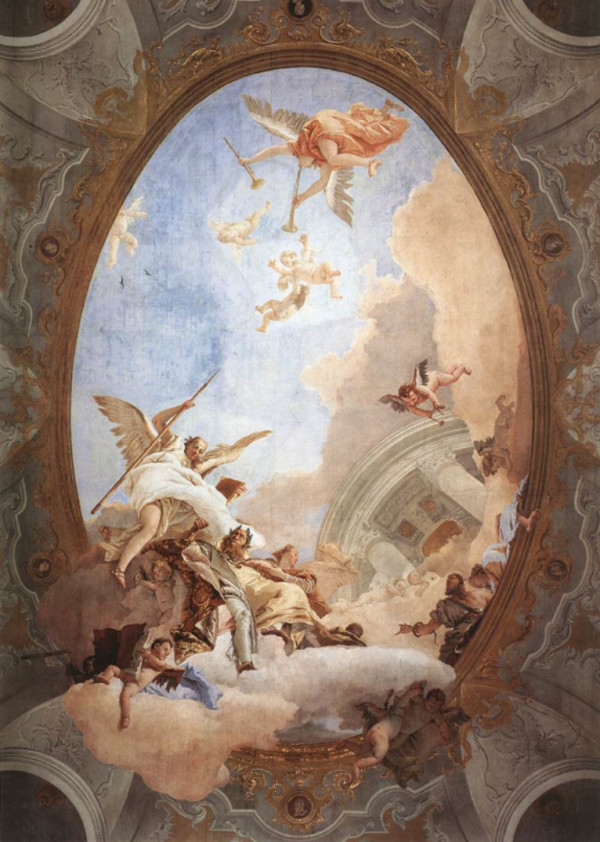
Example of Rococo Art Breaking Frame, Phillip Friederich von Hetsch's Allegory of Merit Accompanied by Nobility and Virtue (1758).